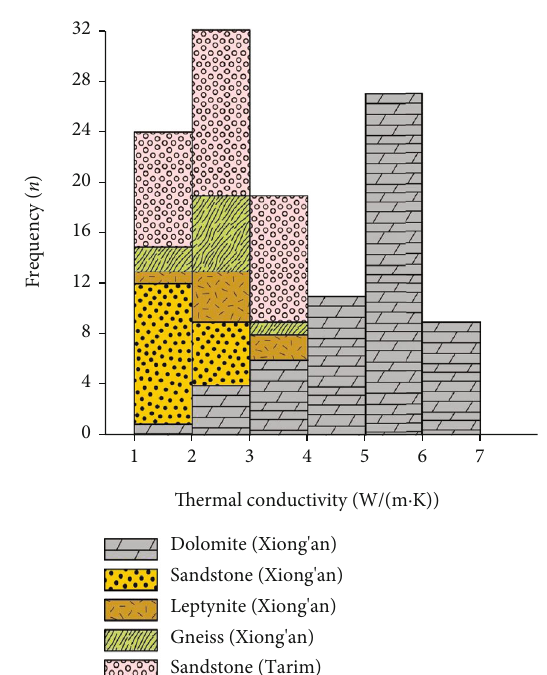
Figure 6: Distribution histogram of thermal conductivity of di ff erent rocks.